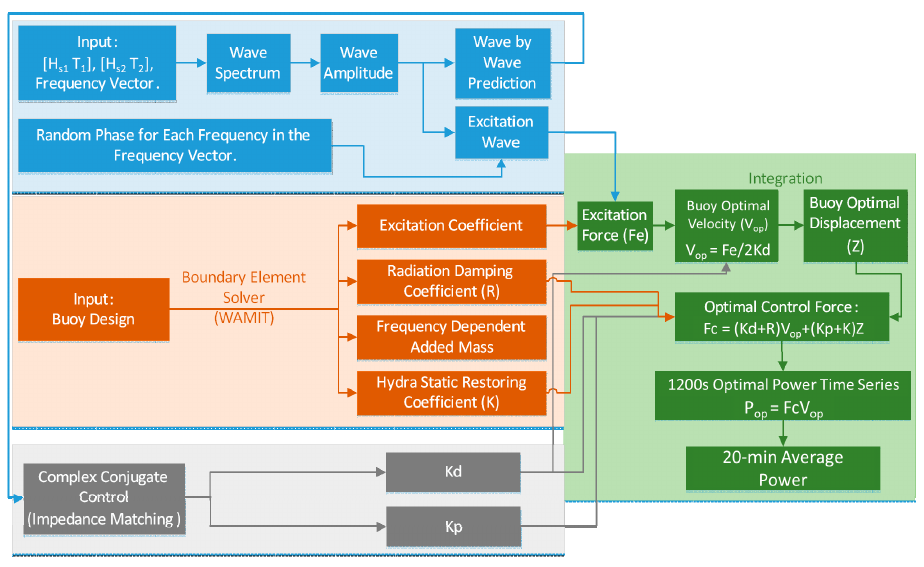
Figure 3. Power generation code flow chart.